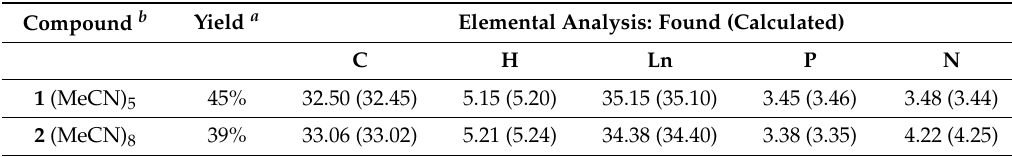
Table 1. Elemental analysis and yield (%) for compounds 1 and 2